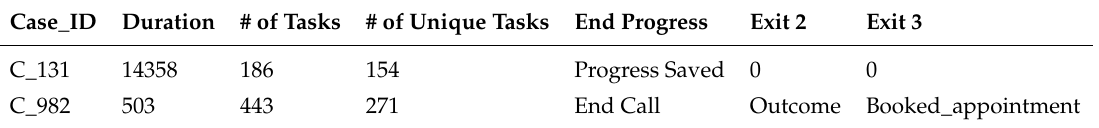
Table 6. Most dissimilar cases identified by the Gower Distance